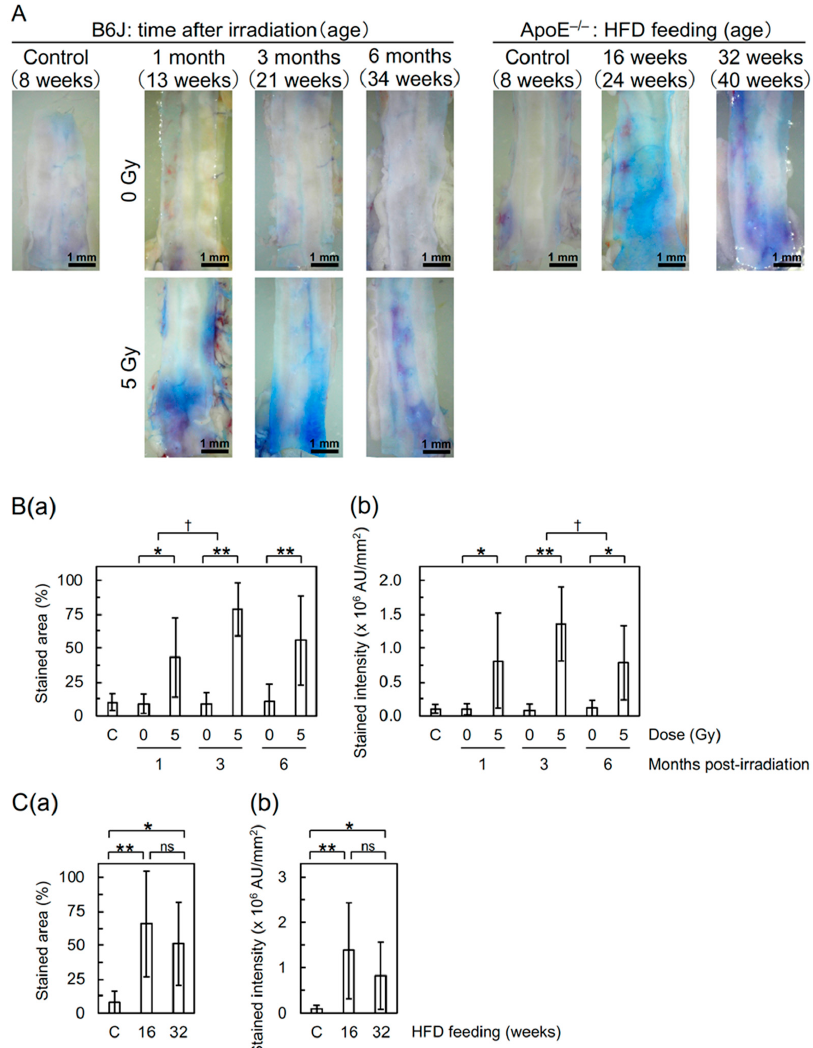
Figure 2. Changes in vascular permeability in the descending thoracic aorta of B6J and ApoE − / − mice evaluated with the Miles assay. ( A ) Representative images of extravasated dye. ( B ) Quantitative analysis for ( a ) stained area and ( b ) intensity ( b ) in B6J mice. 10 mice / group analyzed. According to the one-way ANOVA, a di ff erence among three post-irradiation timepoints in irradiated groups was significant for stained area (ANOVA p = 0.03, pairwise p = 0.02 for 1 vs. 3 months) and nonsignificant for stained intensity (ANOVA p = 0.07), but a di ff erence among four (1 non-irradiated and 3 sham-irradiated) control groups was nonsignificant for both stained area and intensity (ANOVA p > 0.5). ** p < 0.001 or * 0.001 ≤ p < 0.05 for irradiated vs. sham-irradiated groups at each timepoint (by the two-sample t -test). † 0.001 ≤ p < 0.05 for the degree of a di ff erence between irradiated and sham-irradiated groups at two timepoints (pairwise p ). ( C ) Quantitative analysis for ( a ) stained area and ( b ) intensity ( b ) in ApoE − / − mice. 10–13 mice / group analyzed. ** p < 0.001, * 0.001 ≤ p < 0.05, or ns (nonsignificant, p > 0.1) between two groups (by the two-sample t -test). A di ff erence between non-irradiated B6J (Figure 2(Ba,Bb)) and normal-fat diet-fed ApoE − / − (Figure 2(Ca,Cb)) controls was not significant ( p > 0.5). AU, arbitrary unit. C, non-irradiated or normal-fat diet-fed controls. HFD, high-fat diet. Next, to evaluate the molecular changes, the aorta was subjected to dual immunofluorescent staining for cluster of di ff erentiation 31 (CD31) and other markers (Figure 3A). CD31 is a marker for vascular endothelial cells (VECs), and α -smooth muscle actin ( α -SMA) is a marker for vascular smooth muscle cells (VSMCs). Irradiation led to partial loss of the aortic endothelium manifested as loss